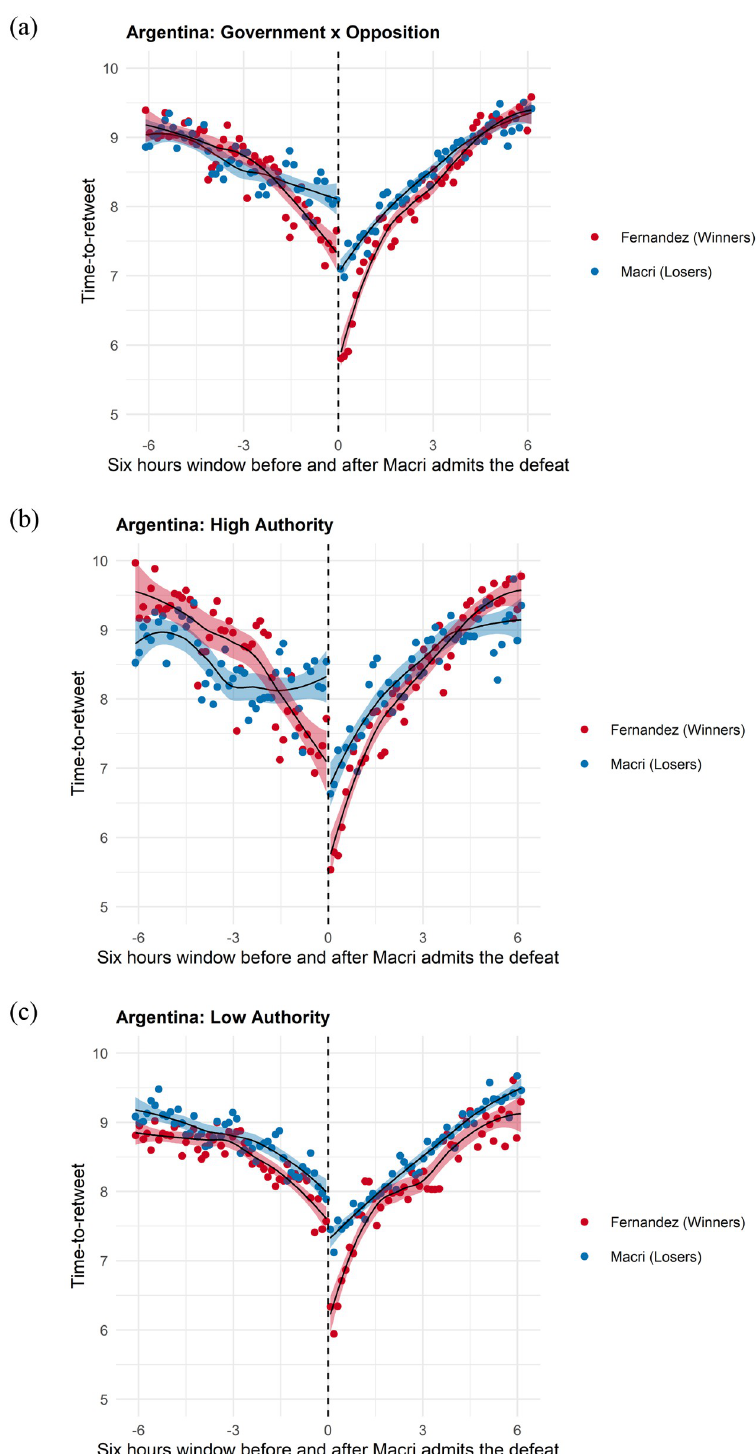
Fig 3. Time-to-retweet in the argentine election. (a) Winners vs Losers, (b) High Authority Users, (c) Low Authority Users.